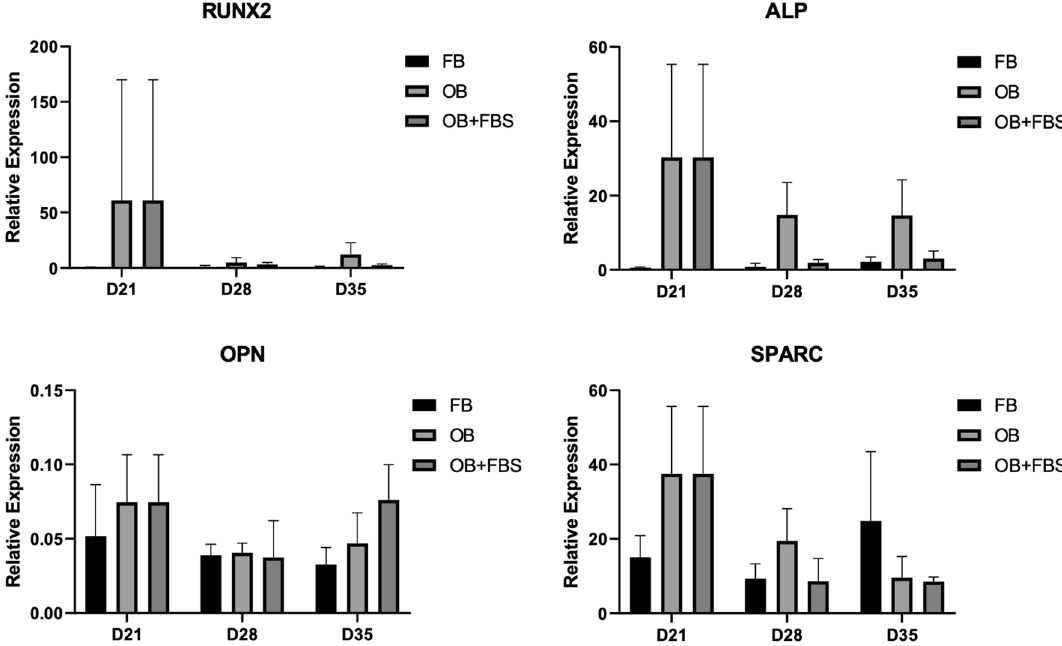
Figure 5. Level of maintenance of osteogenic transdifferentiation per primary cell cultures after day 21. The expression of RUNX2 , ALP , SPARC and OPN was measured in 5 different primary cell cultures from healthy donors on day 28 and 35 after osteogenic transdifferentiation for 21 days, after which the cells were further maintained in the osteogenic media with 5% platelet lysate (OG) or osteogenic media with 10% FBS (FBS); at the indicated timepoints cells were also harvested after culture in fibroblast media (FIB). The expression was measured by qPCR and results were normalized based on the expression of TBP . Error bars indicate the SEM per group of